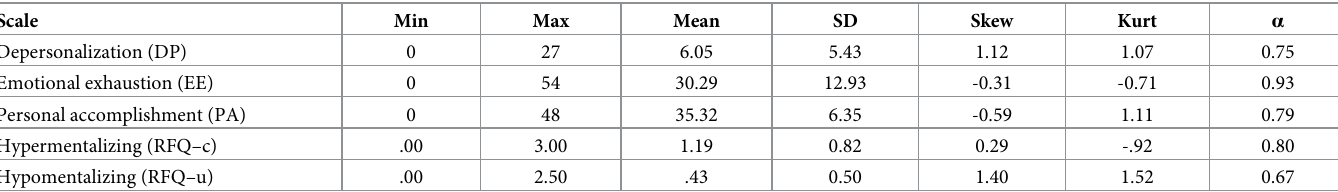
Table 1. Descriptive statistics of used